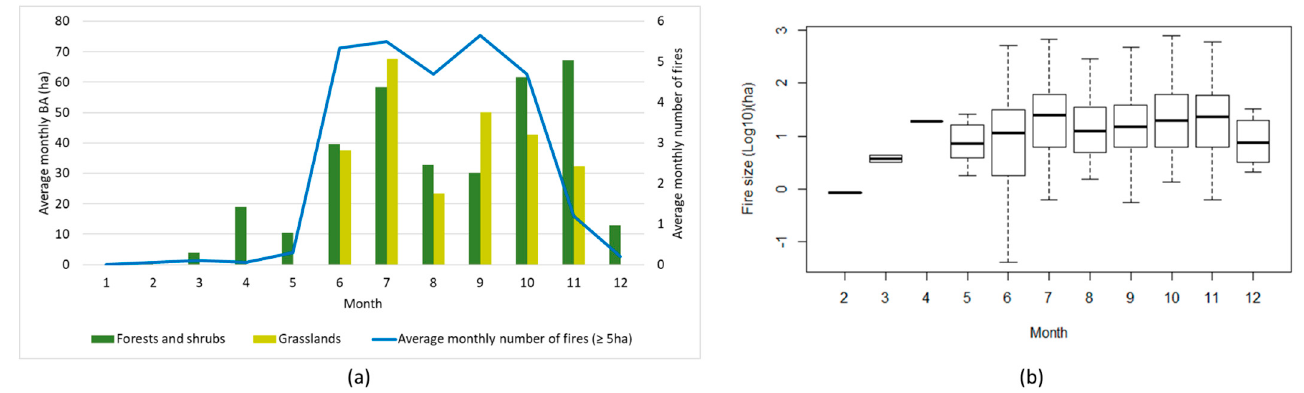
Figure 7. ( a ) The average monthly number of fires (blue) and burnt area (ha) (Y-axis) in for- ests/shrublands (dark green) and grasslands (light green); ( b ) boxplots representing the monthly median, standard deviation, 95% confidence interval and outliers of fire size (Y-axis, log10 scale, ha) in Lebanon for the 2001–2020 period. Table 5. Monthly average BA (±SD) (ha) and monthly average NBF (number of fires; ≥ 5 ha) (±SD) in Lebanon during the fire season for the period 2001–2020. SD: standard